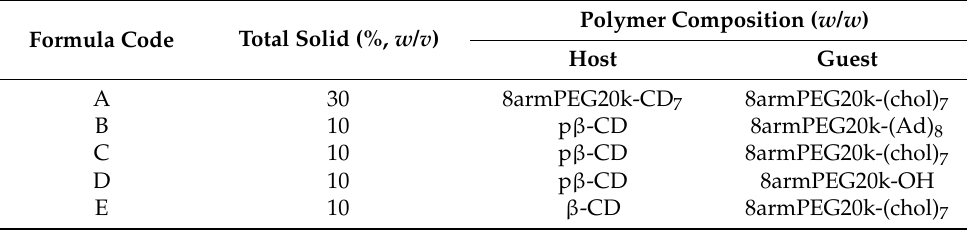
Table 6. Composition of different hydrogel systems from equal weight (ratio 1:1 w / w ) of two inclusion complexation partners (host and